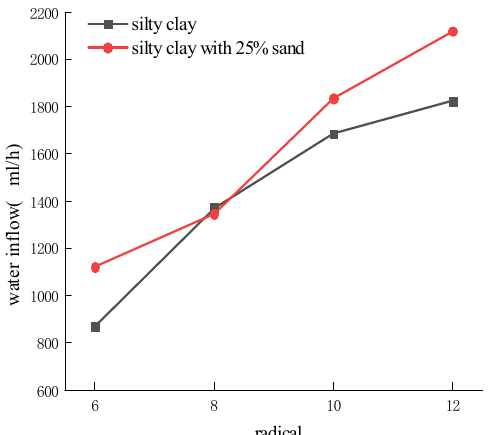
Figure 22. A seepage effect diagram of strand-shaped hemp rope fiber bundle.